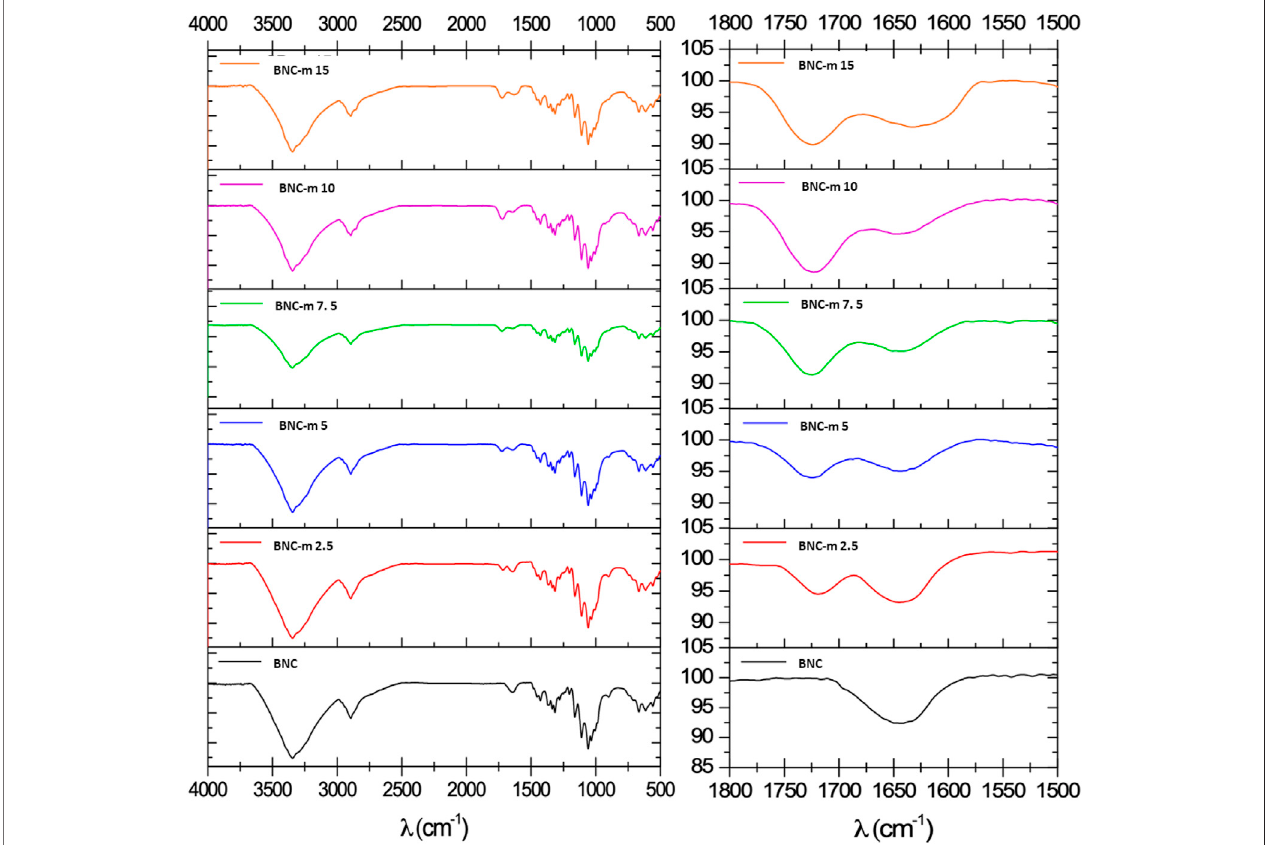
FIGURE 2 | IR spectra of the BNC and BNC-m membranes. Left, full spectrum and right, extension area 1800 – 1500 cm -1 .